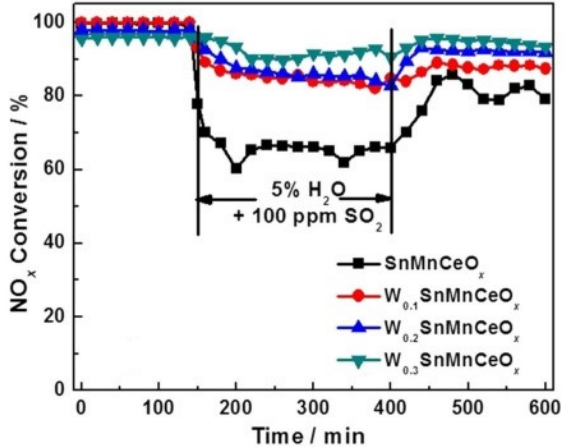
Figure 31. NH 3 –SCR activity over W y SnMnCeO x catalysts in the presence of SO 2 /H 2 O at 200 °C (Reaction conditions: [NO] = [NH 3 ] = 500 ppm, [O 2 ] = 5%, [SO 2 ] = 100 ppm (when used), [H 2 O] = 5% (when used), N 2 balance, total flow rate 100 mL min − 1 and GHSV = 60,000 mLg − 1 h − 1 ). (Reproduced with permission from Reference [53], Copyright 2017, Elsevier.).